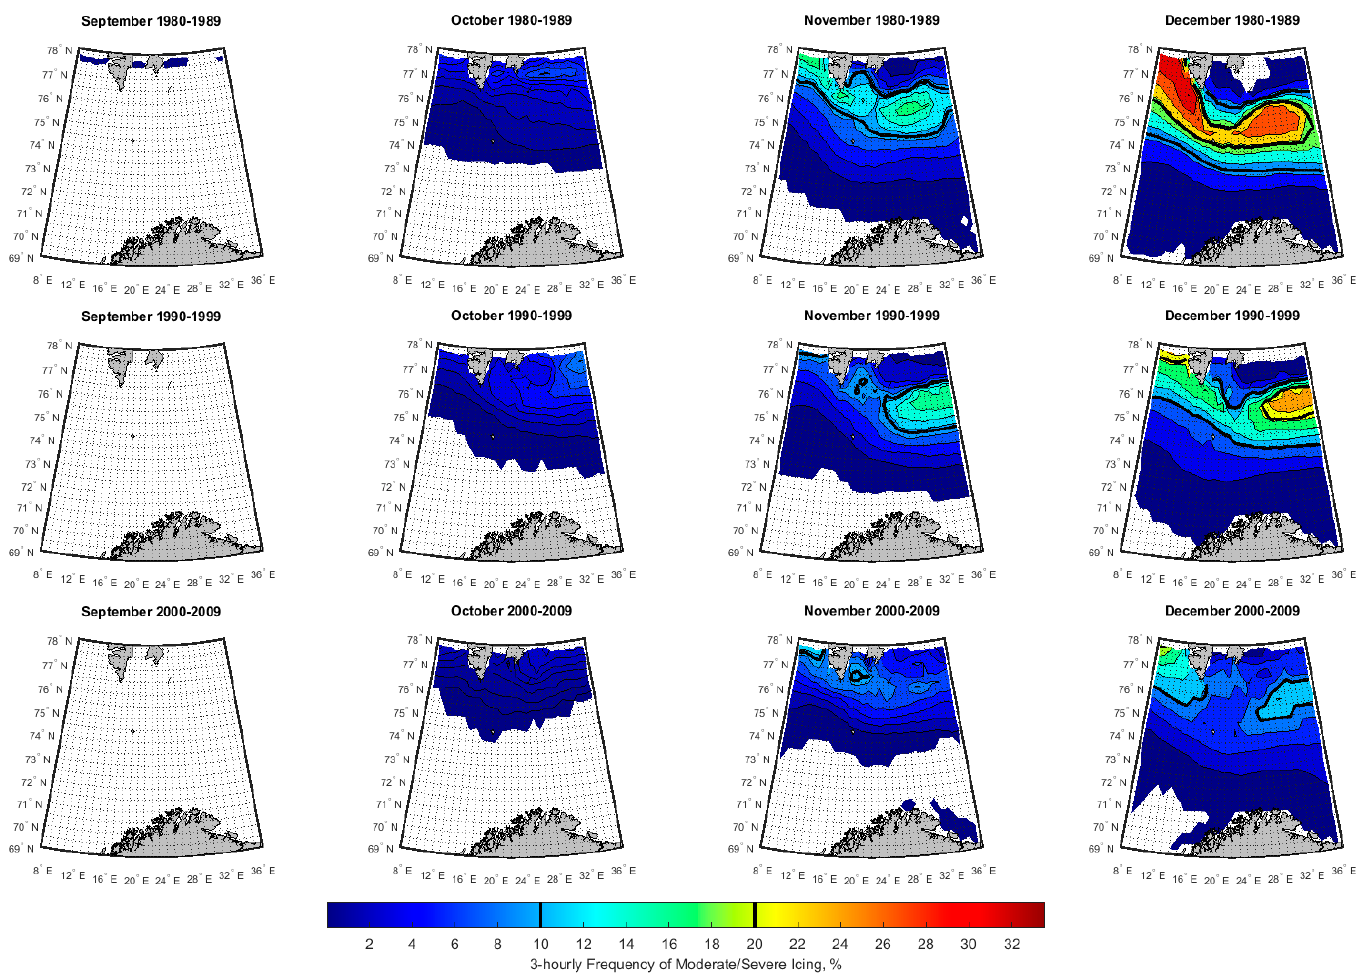
Figure 18. Three-hourly frequency of moderate and severe icing events in each region during the 1980s, 1990s, and 2000s (Sep, Oct, Nov, Dec).